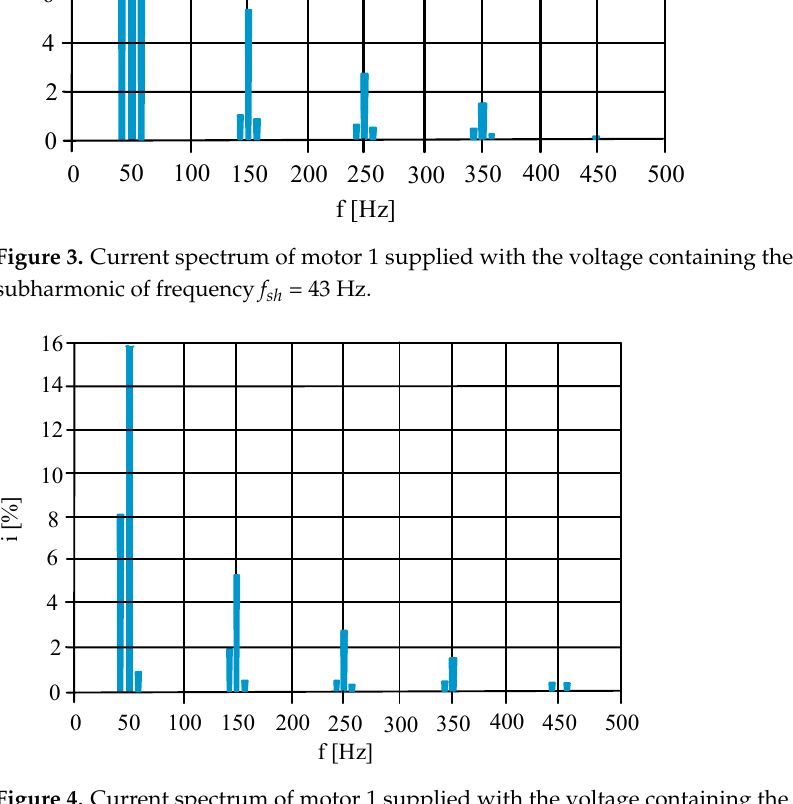
Figure 4. Current spectrum of motor 1 supplied with the voltage containing the negative sequence subharmonic of frequency f sh = 43 Hz.